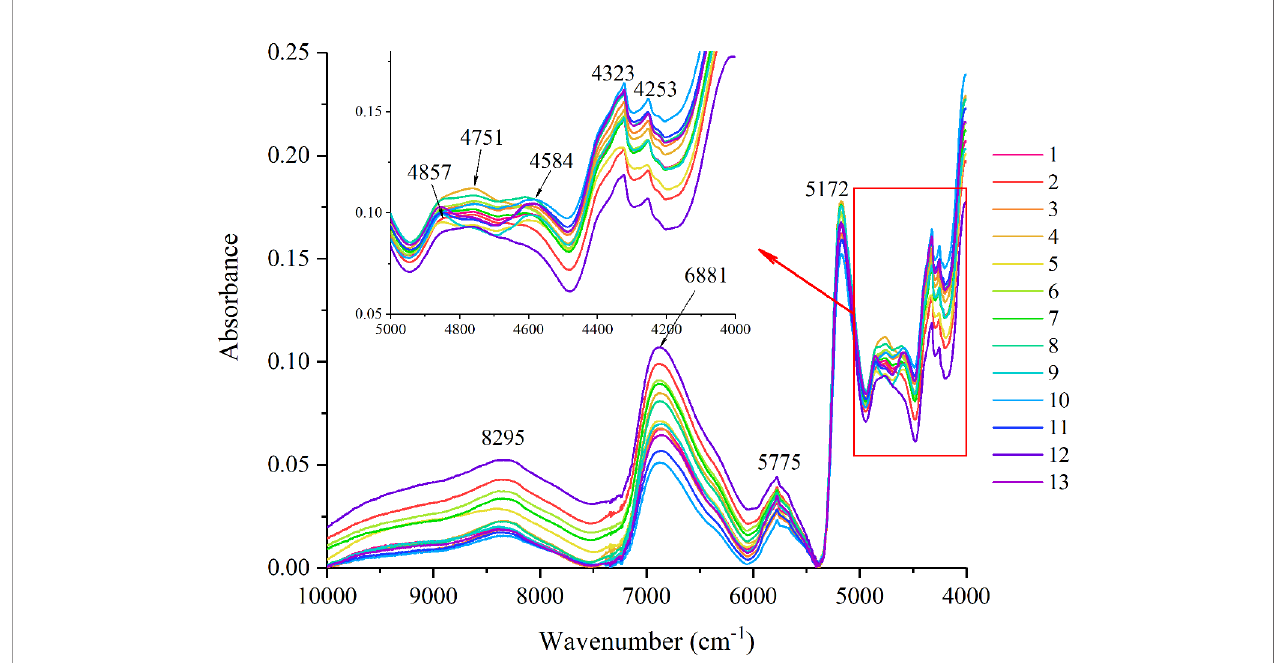
FIGURE 1 | Stacked Fourier transform near-infrared (FT-NIR) spectra of Eucommia ulmoides leaves (EUL) from thirteen geographical regions.